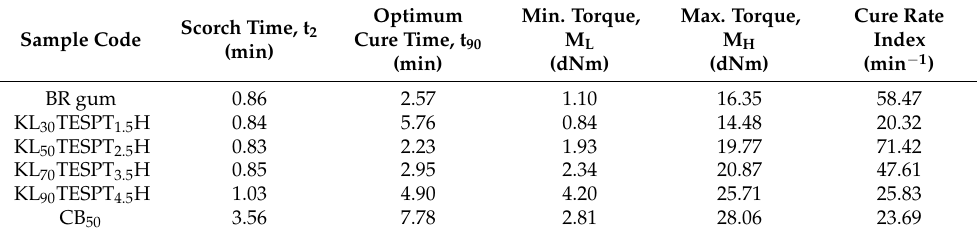
Table 2. Curing characteristics of BR/kraft lignin/TESPT composites with various lignin